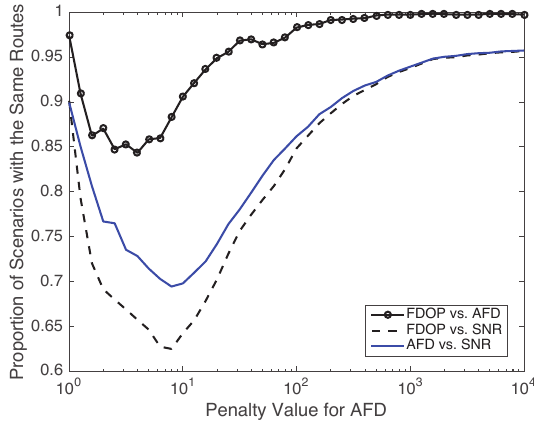
Figure 3. Variation of penalty for four sources and four